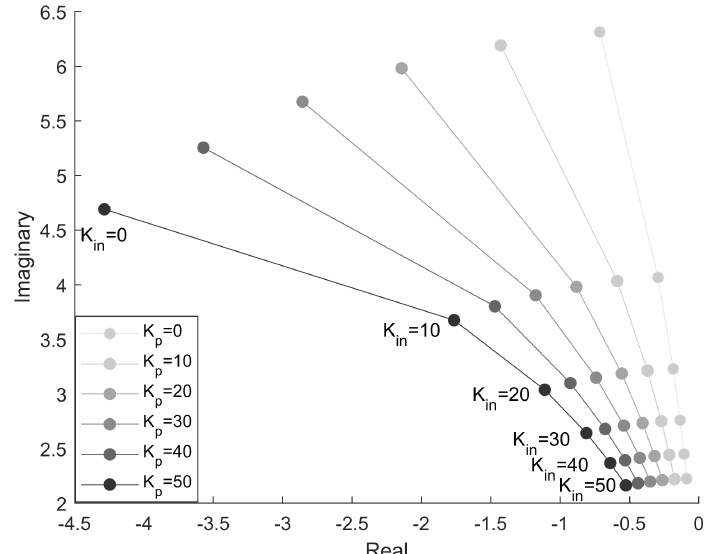
Figure 2. Sensitivity analysis of λ SMIB to K p and K in .